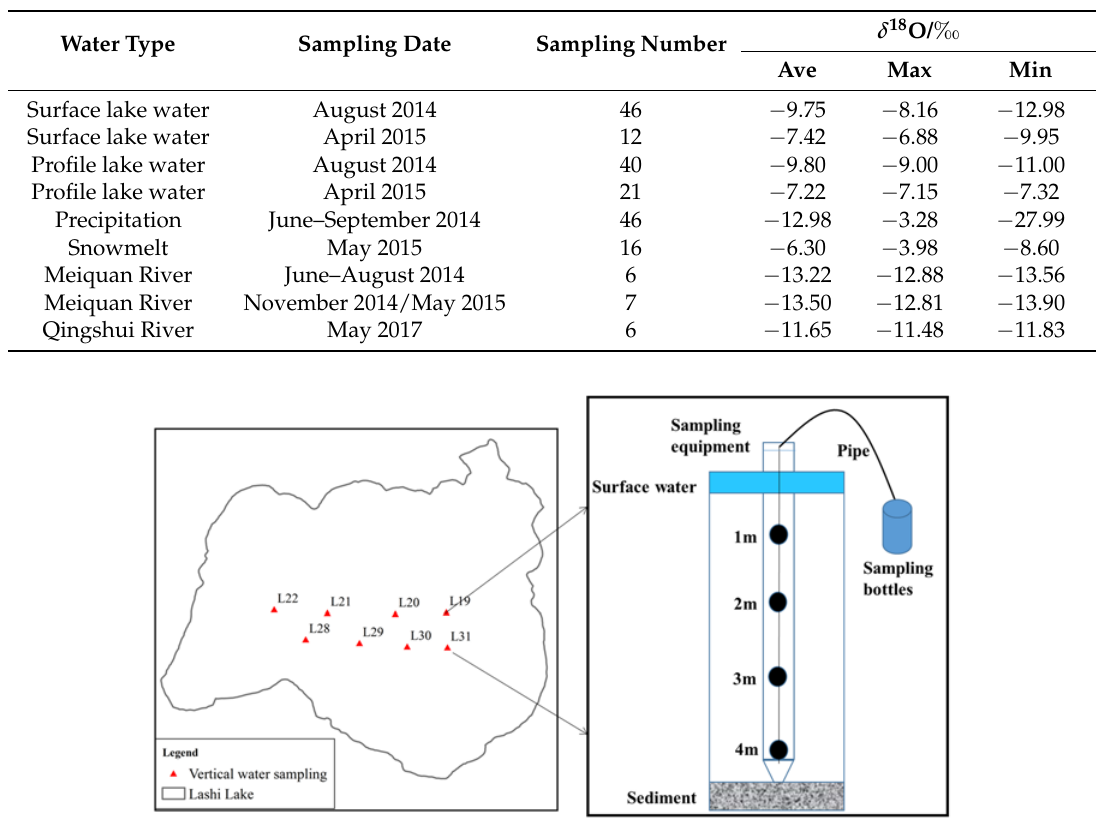
Table 1. Values of δ 18 O for snowmelt, lake water, rainfall and river water samples.